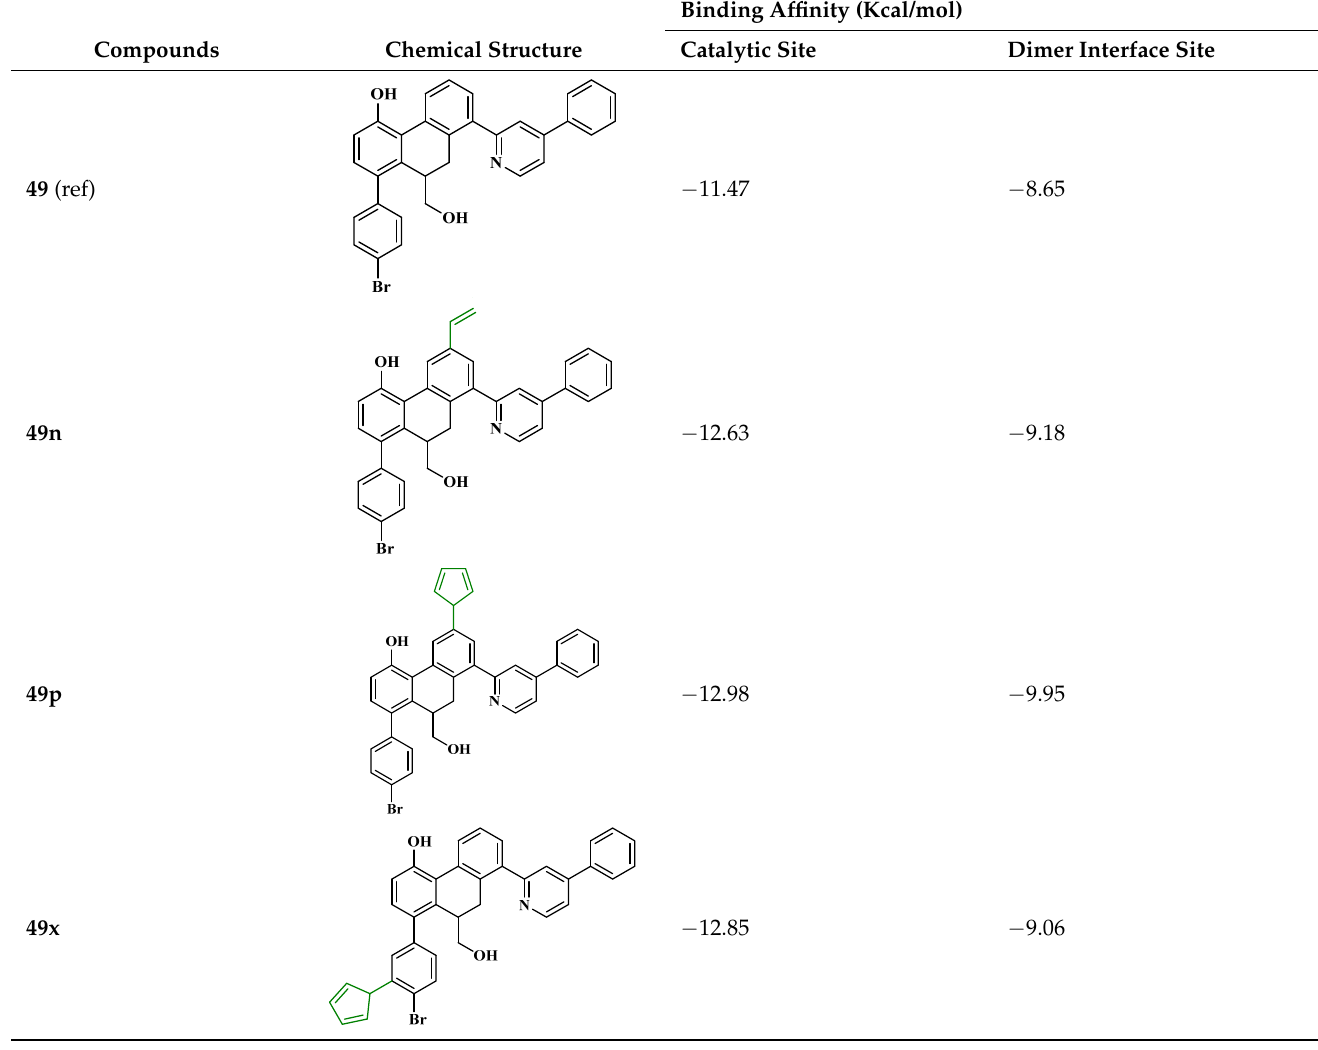
Table 4. The newly designed compounds and their predicted pIC 50 using the Monte Carlo optimization and the GA-MLR models.